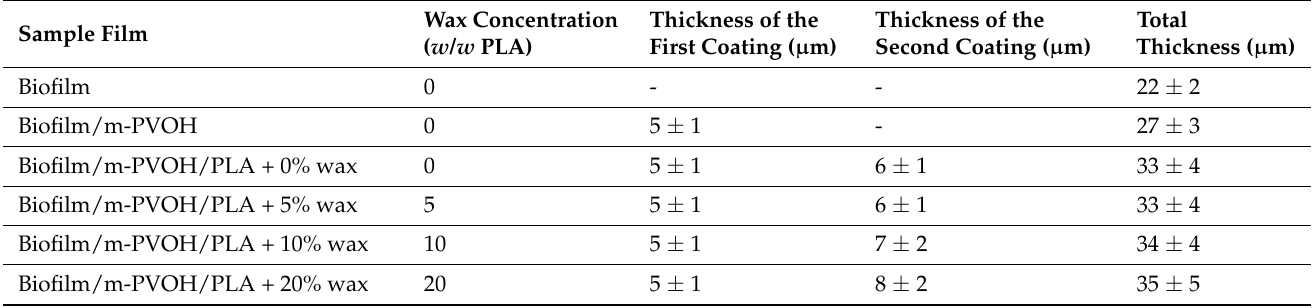
Table 1. List of the multilayer films produced with coating dry thickness measurements. The neat substrate (Biofilm) was used as a